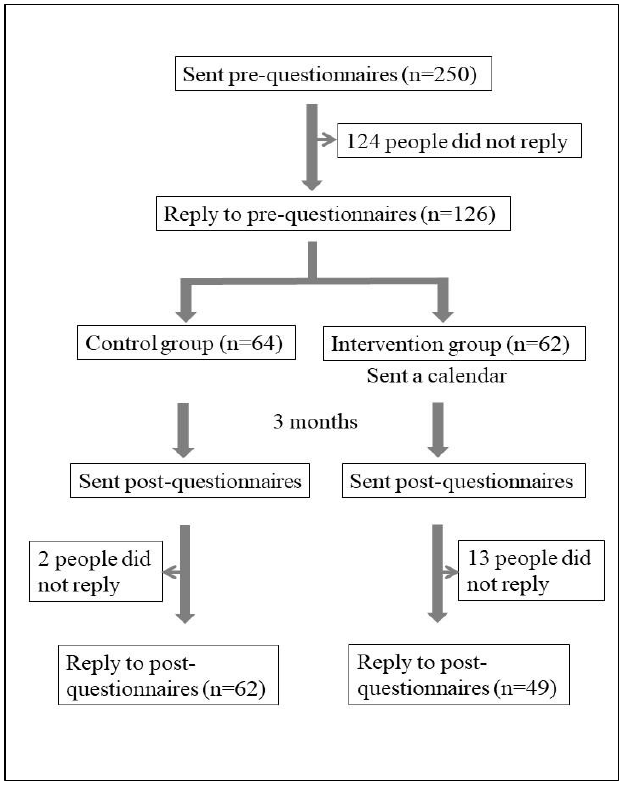
Figure 1. Flow chart showing the participants recruited in the study.